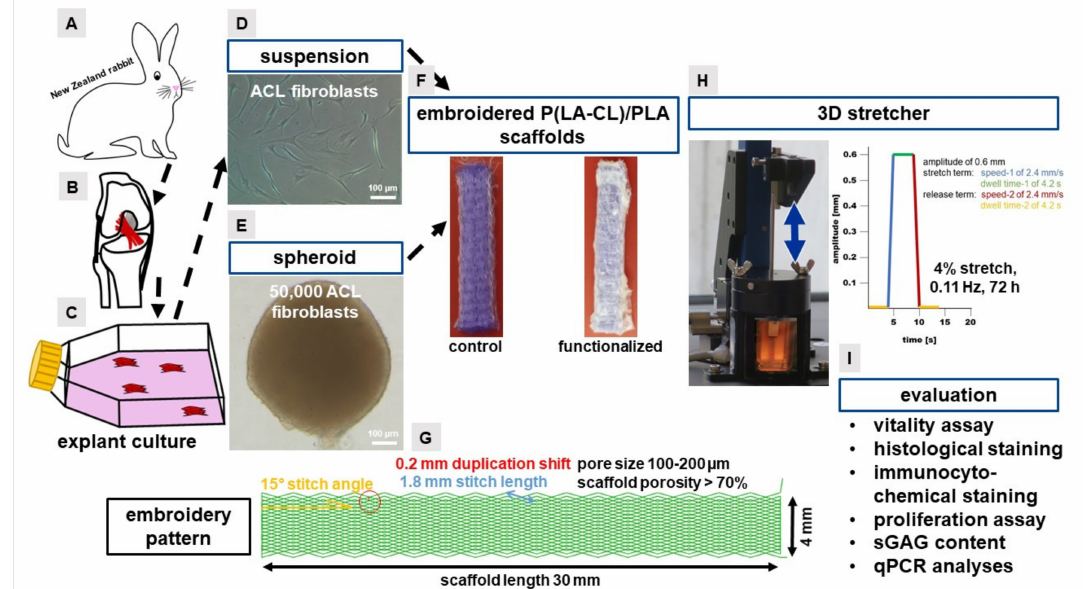
Figure 1. Scheme of the experimental setting. New Zealand rabbits ( A ) are the tissue and cell donors for this study. The anterior cruciate ligament (( B ), marked in red) was dissected from the knee joint and cultured via explant culture ( C ). Two cultivation strategies, the suspension ( D ) and the spheroid culture ( E ) were performed for scaffold coloniza- tion. Non-functionalized (control) and functionalized embroidered poly( L -lactide-co- ε -caprolactone (P(LA-CL)) scaffolds (30 mm × 4 mm × 1 mm) were compared ( F ). The scaffold embroidery ( G ) consisted of a zigzag pattern with 1.8 mm stitch length, 15 ◦ stitch angle and 0.2 mm duplication shift. After pre-cultivating the scaffolds with cells, scaffolds were put into a 3D stretcher and 4% stretched (0.11 Hz) for 72 h ( H ). The cycle starts with a pause time (=dwell time-2 of 4.2 s, yellow line). In this phase the scaffolds were in a “zero position”. Then, the scaffolds were stretched with a speed of 2.4 mm/s (blue line) to reach the defined stretch position of 4% (0.6 mm amplitude). The stretched scaffold remained in this position for 4.2 s (=dwell time-1, green line). Then, the scaffolds were transferred to the starting position with a speed of 2.4 mm/s (red line) and left in this position for 4.2 s (=dwell time-2, yellow line). This stretch cycle was continuously repeated for 72 h ( H ). Evaluation ( I ) included vitality assay, histological staining, immunocytochemical staining, DNA and sulphated glycosaminoglycan (sGAG) content measurements and real time polymerase chain reactions